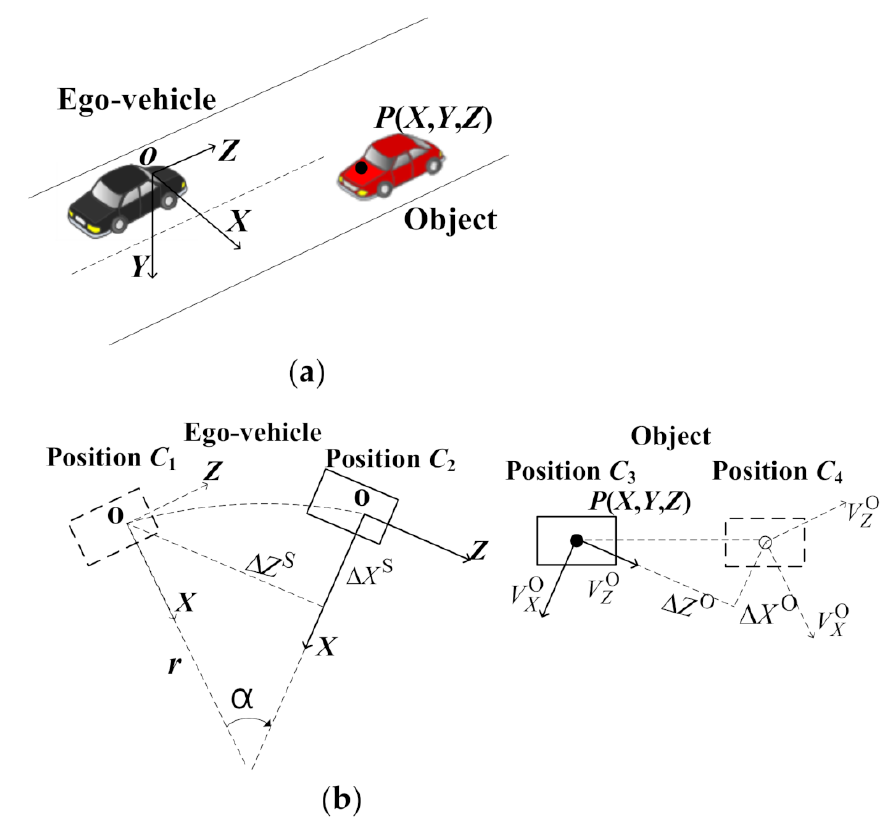
Figure 4. Relative motion model. ( a ) The camera coordinates. ( b ) Relative motion between ego- vehicle and moving